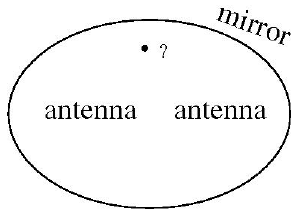
Figure 1. Second order